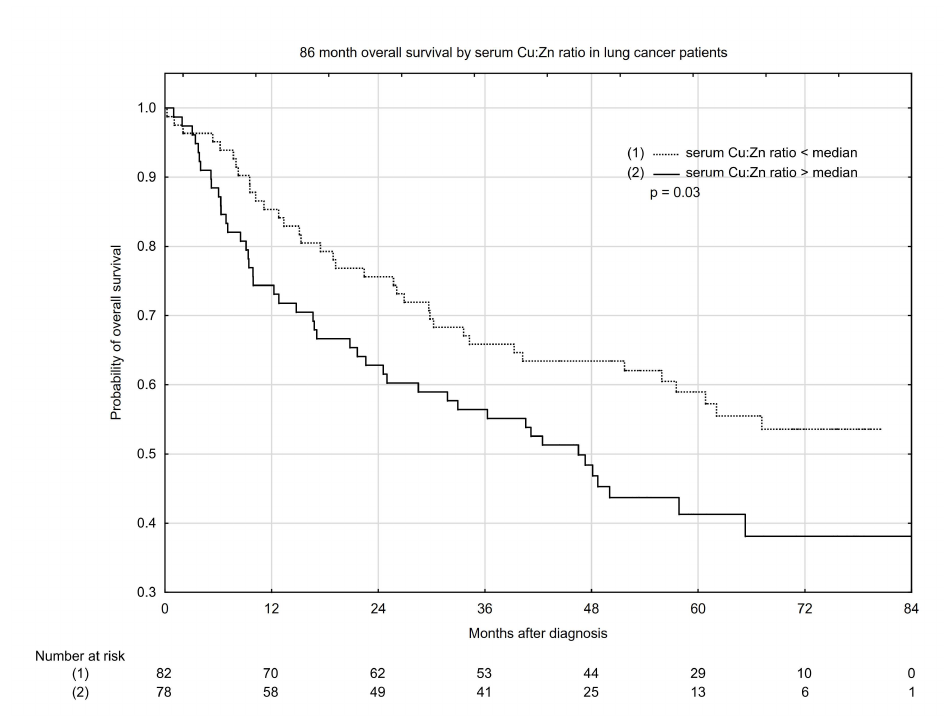
Nutrients 2021 , 13 , x FOR PEER REVIEW Figure 2. Eighty-six-month overall survival by serum Cu:Zn ratio in lung cancer patients.